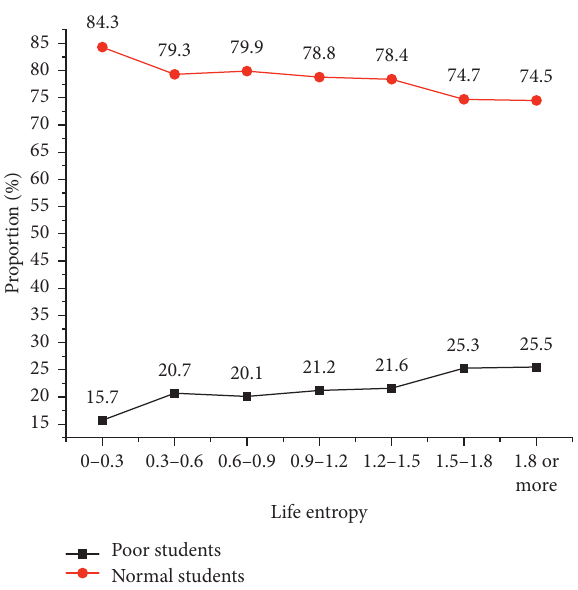
Figure 8: Proportion of poor students in different life entropies.